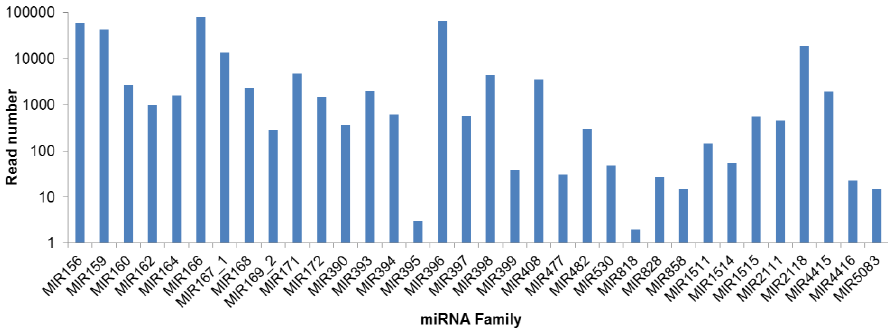
Figure 3. The read counts of each conserved miRNA family in A. membranaceus .